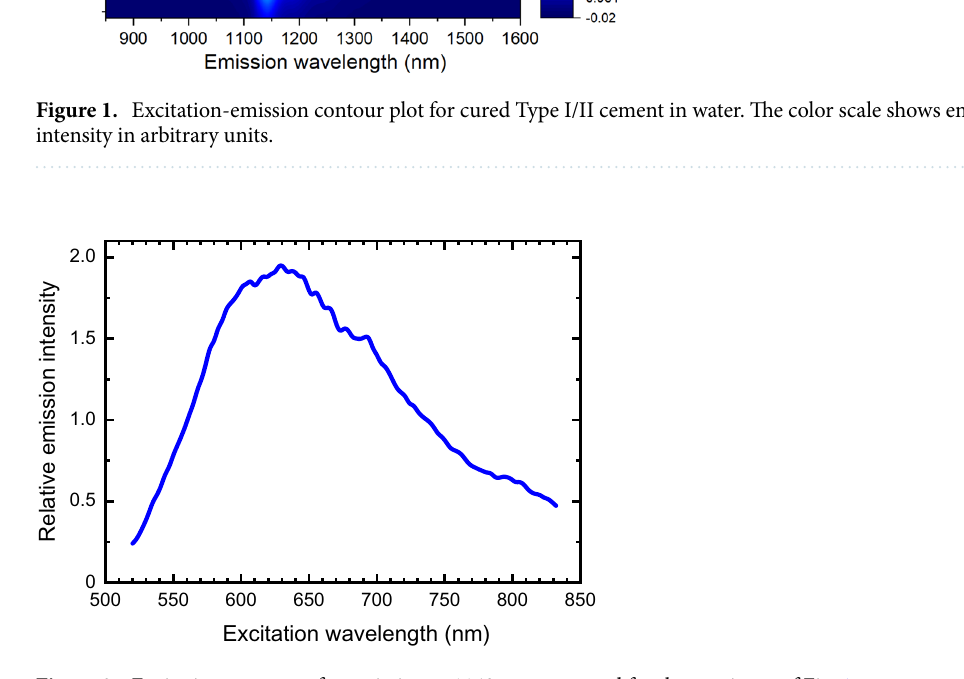
Figure 2. Excitation spectrum for emission at 1140 nm measured for the specimen of Fig.